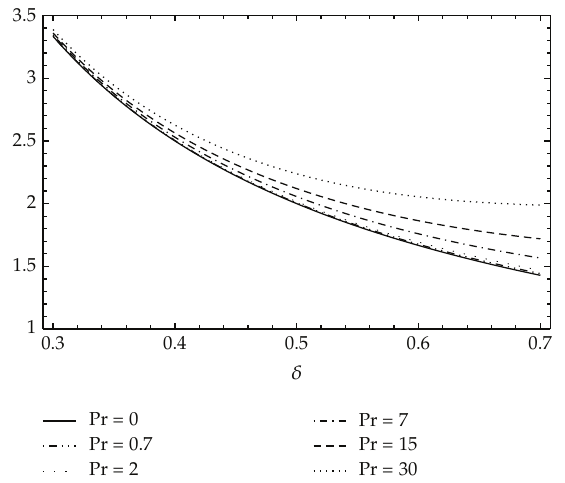
Figure 7: The temperature gradient on the disk (cid:3) θ (cid:2) (cid:3) 0 (cid:4)(cid:4) obtained by the 8th-order approximation of the HPM for di ff erent values of the Prandtl